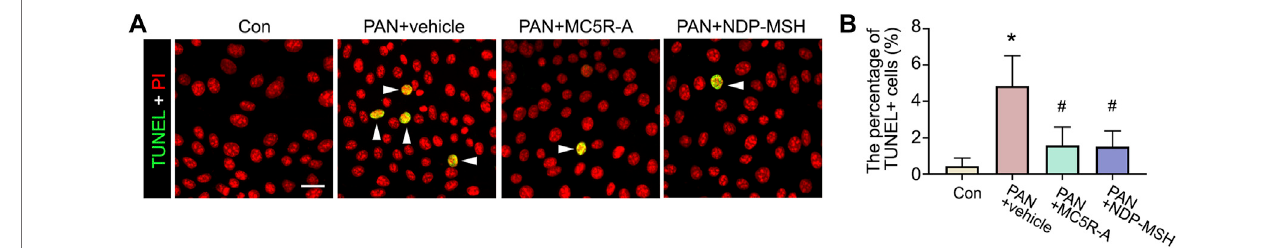
FIGURE5 | Podocyteapoptosis elicited byPAN isattenuated by theMC5Ragonist.Cells were treated asdescribed inFigure4. (A) Cells with different treatments were fi xed and subjected to TUNEL staining counterstained with PI (Scale bar = 50 μ m); The arrowheads indicate TUNEL positive cells. (B) The percentage of TUNEL positive (+) cells per microscopic fi eld. p p < 0.05 versus control (Con) group; # p < 0.05 versus PAN + vehicle group ( n = 3).